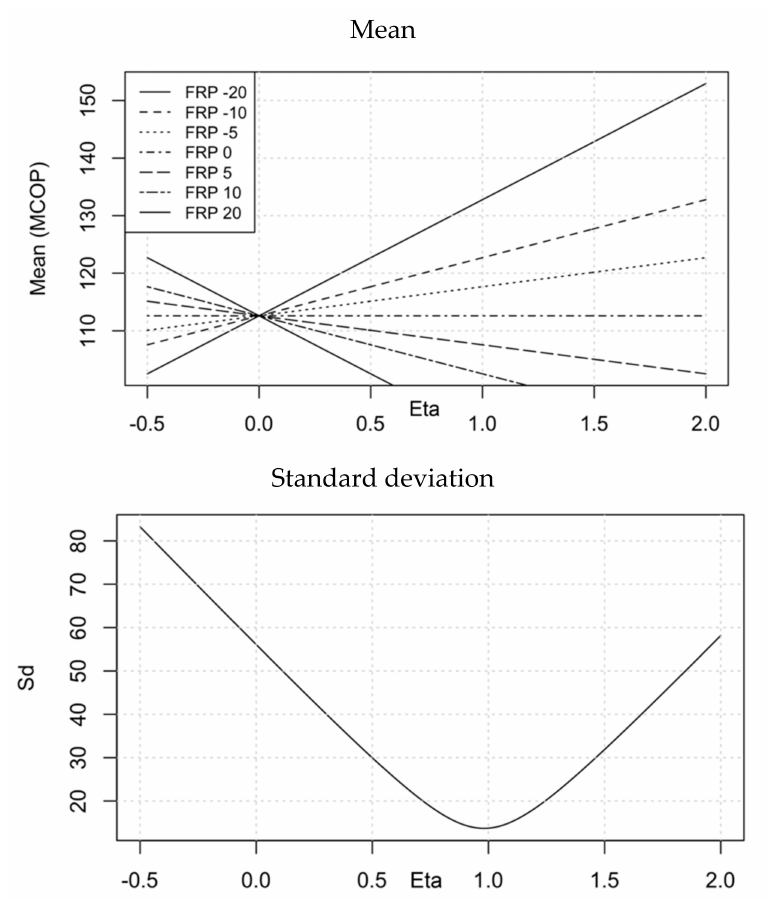
Figure 5. Sensitivity of the mean and the standard for Eta and FRP. Simulation of the behavior of the mean and standard deviation at different contracting levels (Eta) and forward risk premium